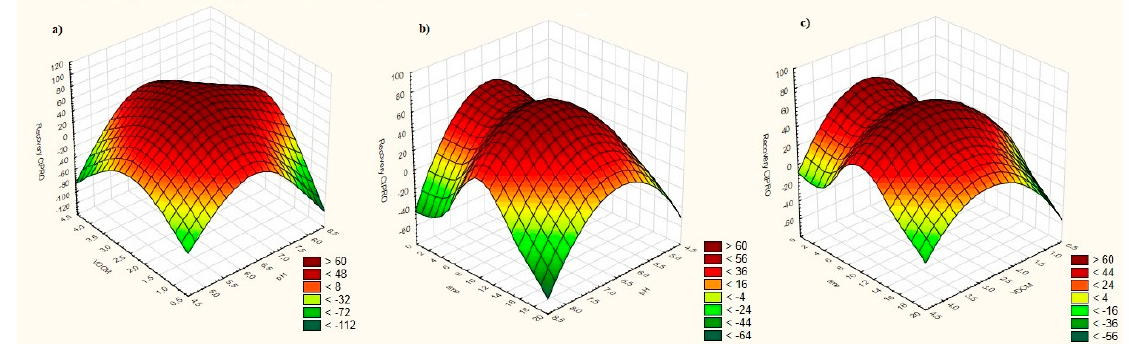
Figure 2. The RSM diagrams illustrating the change of recovery of CIPRO when analyzed: ( a ) VDCM and pH; ( b ) time and pH; ( c ) time and VDCM for CCD. Table 6. The statistical analysis of CCD for the analytes.